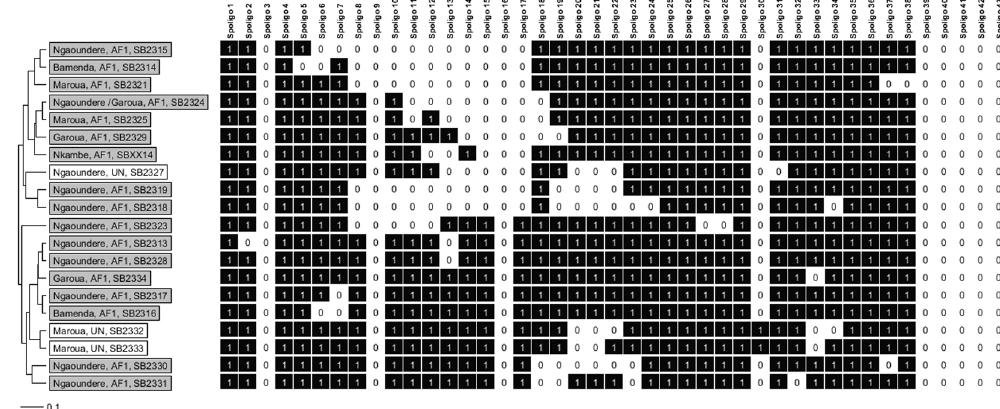
Figure 2. UPGMA phylogenetic tree showing (novel) previously unreported M.bovis spoligotypes cultured from cattle from the four abattoirs sampled in Cameroon between 2012-1013. The gray and white shade represents Africa 1 clonal and Unknown complexes respectively. The tree is based on the standard 43 spoligotype